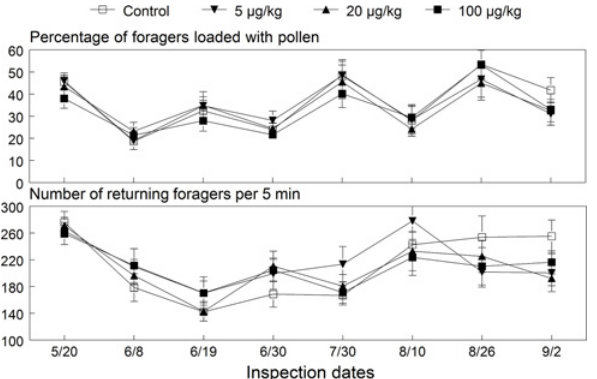
Fig 4. Mean ( ± SE) percentage of foragers with pollen pellets and the number of foragers returning to the 2009 colonies exposed to untreated or imidacloprid-spiked diet patties. ANOVA results for the percentage loaded with pollen (dose: F (3, 93.6) = 0.53, p = 0.662; date: F (7, 176) = 17.81, p < 0.001; interaction: p = 0.993) and number of foragers (dose: F p = 0.733; date: F p F (21, 177) = 0.39, (3, 86.8) = 0.43, (7, 177) = 11.78, p = < 0.001; interaction: F (21, 178) = 1.02,